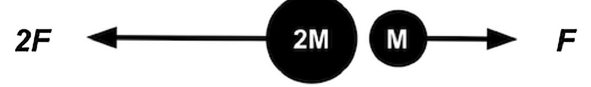
FIG. 1. The system of two masses in the checkpoint